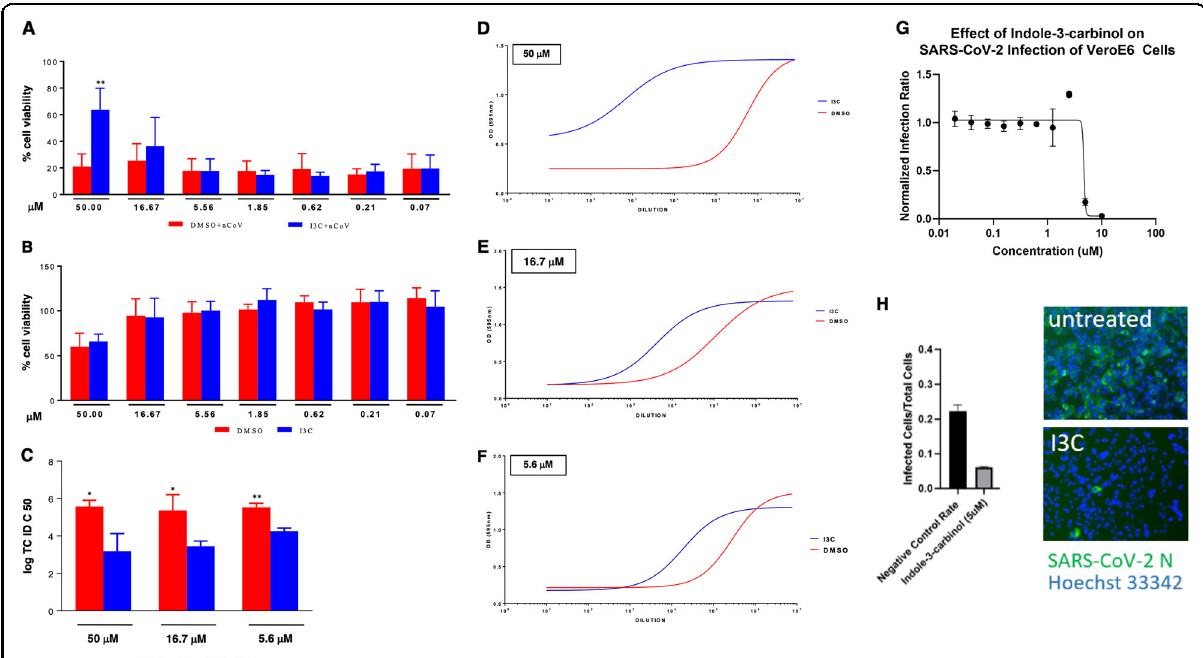
Fig. 6 I3C inhibited SARS-CoV-2-induced CPE and viral production in Vero E6 cells. Cells were treated with different doses of I3C (from 50 to 0.069 μ M; 1:3 serial dilutions) or DMSO (from 0.5 to 6.9 × 10 − 4 v/v percentage) 1 h before SARS-CoV-2 infection (MOI = 0.001) in four replicates. Absorption of the virus was allowed for 1 h at 37 °C in presence of I3C or DMSO treatments. The unabsorbed virus was removed and replaced by fresh medium with I3C or DMSO as above. Cells were then treated with either I3C or DMSO every 24 h and incubated at 37 °C with 5% CO 2 for 72 h when the survival of infected ( A ) or not infected ( B ) cells was measured by crystal violet staining assay. The results were evaluated setting the uninfected control cells as 100% and the remaining values represented as a relative value. Experiments ( n = 4) were performed in triplicate and data are expressed as mean + / − SD. Back-titration of virus progeny released by SARS-CoV-2-infected cells, treated as above, was performed on Vero E6 cells. Survival of the cells was measured by crystal violet staining assay. Results were analyzed using Graph Pad (GraphPad Prism 8 XML ProjecT) with nonlinear regression curve fi t (Inhibitor vs. response-Variable slope (four parameters)) (( D – F ) and data expressed as log TCID 50 /100 μ l ( C )). Statistically signi fi cant differences between DMSO and I3C are represented as * P < 0.05 or ** P < 0.002 determined using the paired t-test. Vero E6 cells were challenged with SARS-CoV-2. After 1.5 d, cells were fi xed, stained with an N speci fi c antibody and Hoechst 33342 for cell nuclei. Infected cells and total cell nuclei were counted by image analysis. The infection ef fi ciency was normalized to infection seen in vehicle (DMSO) treated cells ( G , H